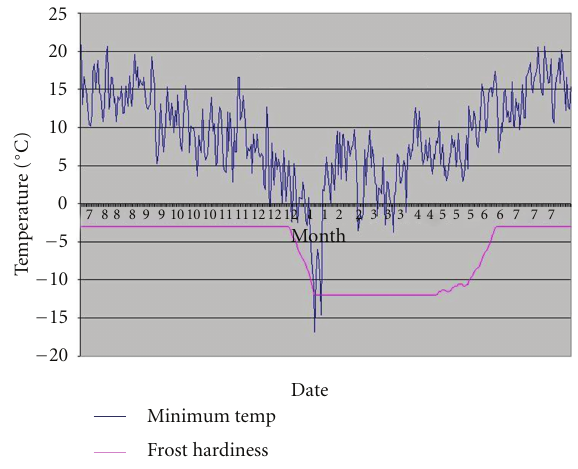
Figure 2: Simulation of frost hardiness and injury for E. pauciflora at Toulouse, France. The frost hardiness line shows how frost toler- ance develops as daily minimum temperatures fall in winter and is lost as they rise in spring. Frost damage is expected if the minimum temperature falls below the frost hardiness line (Figure from